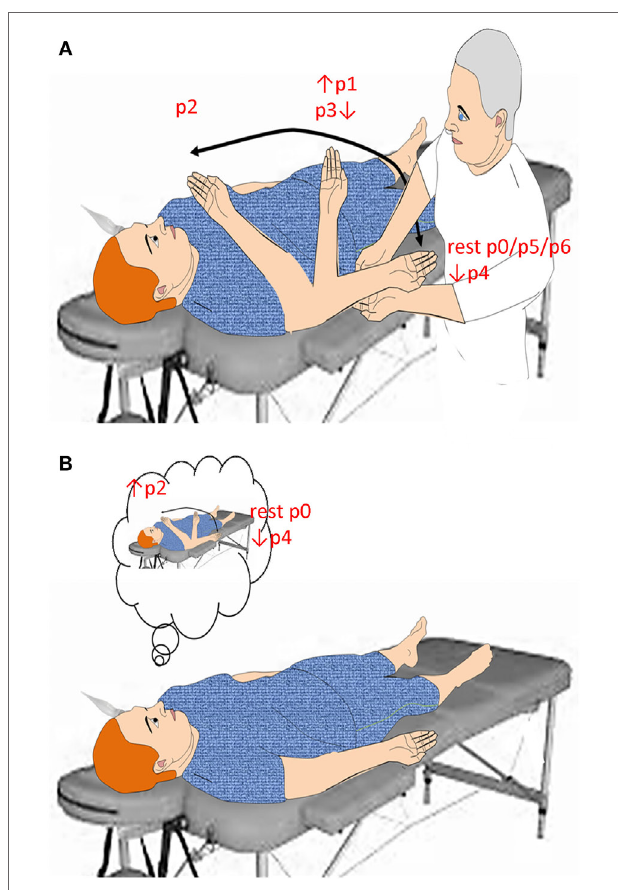
FigUre 1 | Summarizes the experimental paradigm. Concerning passive movement task (a) , the subject was verbally instructed to keep the eyes open, to relax, and to be prepared to be moved the right upper limb from trunk toward the face and vice versa. The speed of passive movement was kept as constant as possible. When the hand reached a predetermined position (p), the examiner kept hold of the participant’s forearm up to the next movement onset, which occurred every 15 heartbeats. Concerning motor imagery task (b) , the subject was provided with two sequential instructions, provided every 15 heartbeats: (i) move your right hand toward the face and keep hold of it, and (ii) came back where you started. All instructions were 2 s in length and presented by